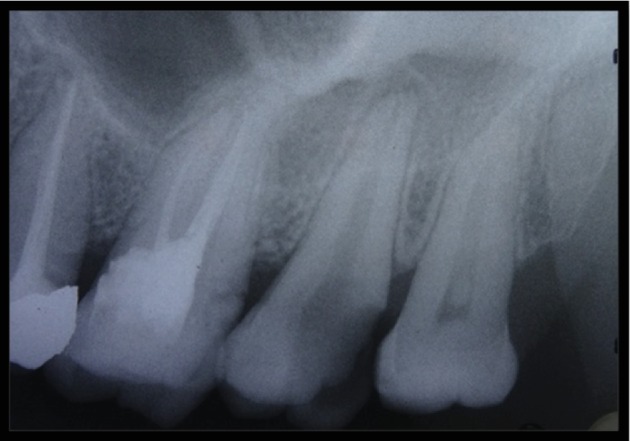
Preoperative IOPA.